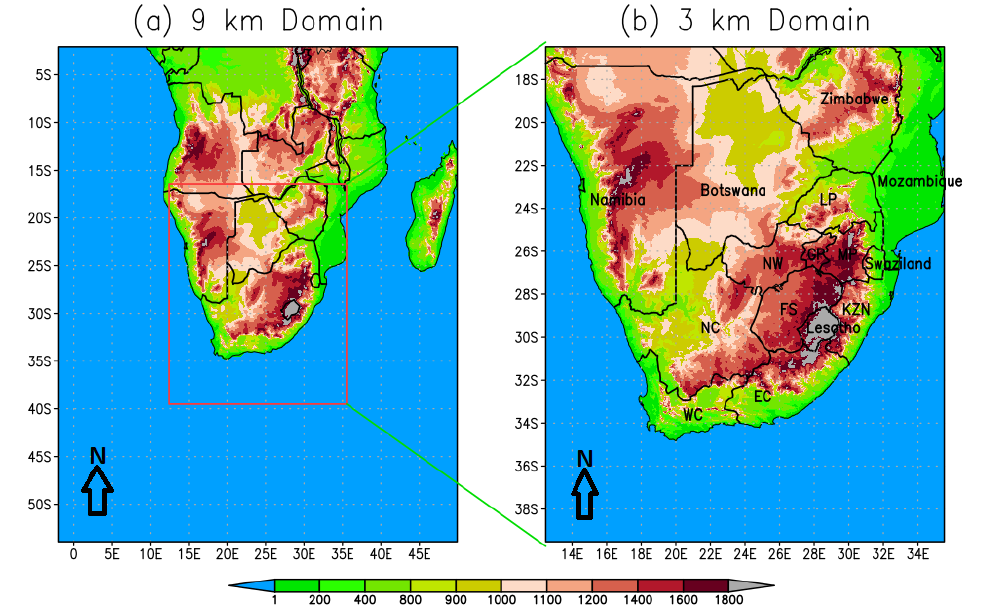
Figure 1. The simulation domain where CCAM runs with the highest resolution, with 9 km resolution across southern African and 3 km across South Africa. The colored contours are altitude above sea level in